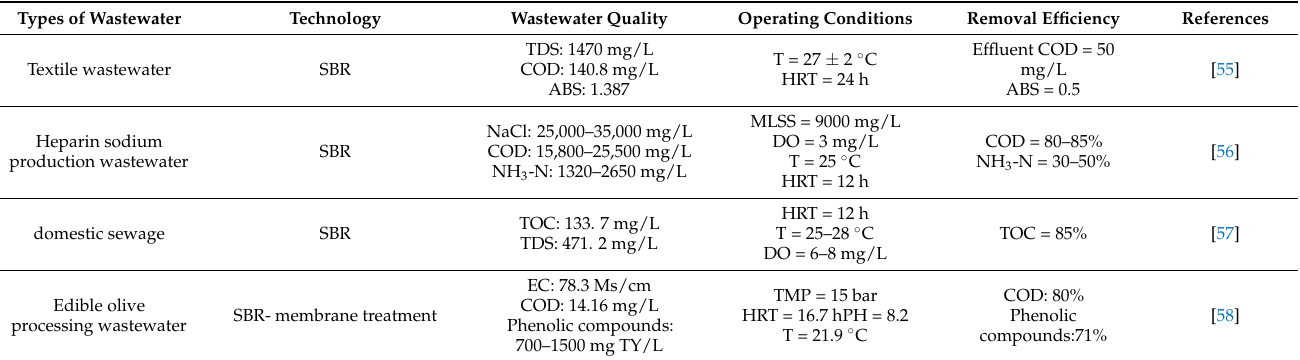
Table 5. Performance and experimental conditions of SBR for the treatment of saline